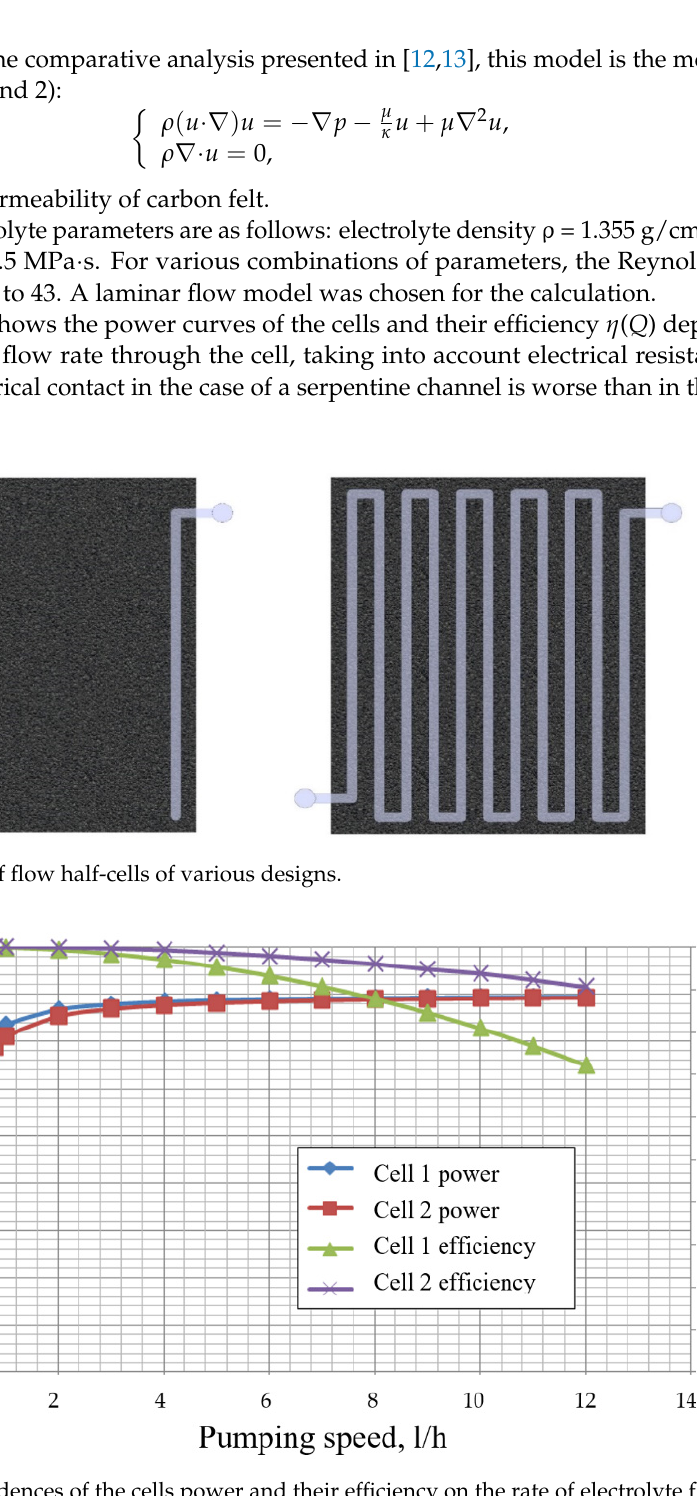
4 of 15 Figure 2. Hydrodynamic scheme of the stand: 1—flow battery stack; 2—tanks with electrolyte; 3—main electrolyte pumps; 4—balancing pump; 5—electrolyte flow sensors; 6—pressure sensors; 7—outlet pipes R-32; 8—branch pipes with an outlet in the form of a fitting; 9—branch pipes KD-10 with pressure relief valves.